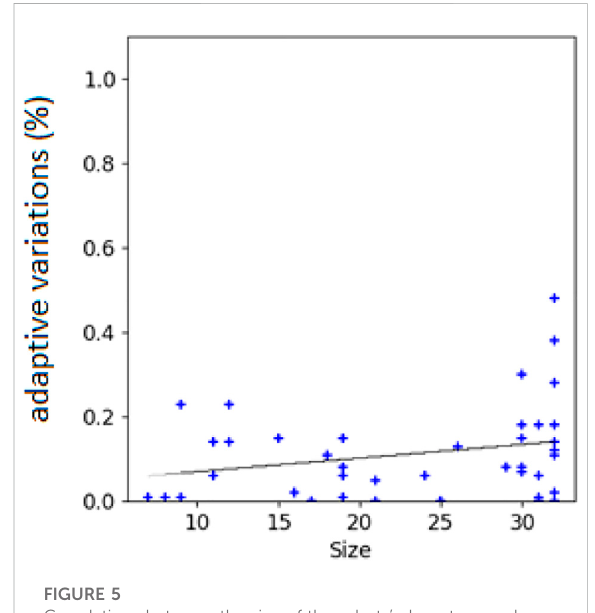
FIGURE 5 Correlations between the size of the robots ’ phenotype and the percentage of adaptive variations. Data computed by subjecting the agents of intermediate generations to single genetic variations for 1000 times. Intermediate generations refer to generation totg/2, where totg correspond to the total number of generations. The black line indicates the linear interpolation of the data. Data obtained by analyzing 40 robots evolved with the (20+20) and (1+4) evolutionary strategy and evolved with the standard and complexity-biased algorithm (i.e. the robots produced in the four experimental conditions, 10 replications for each